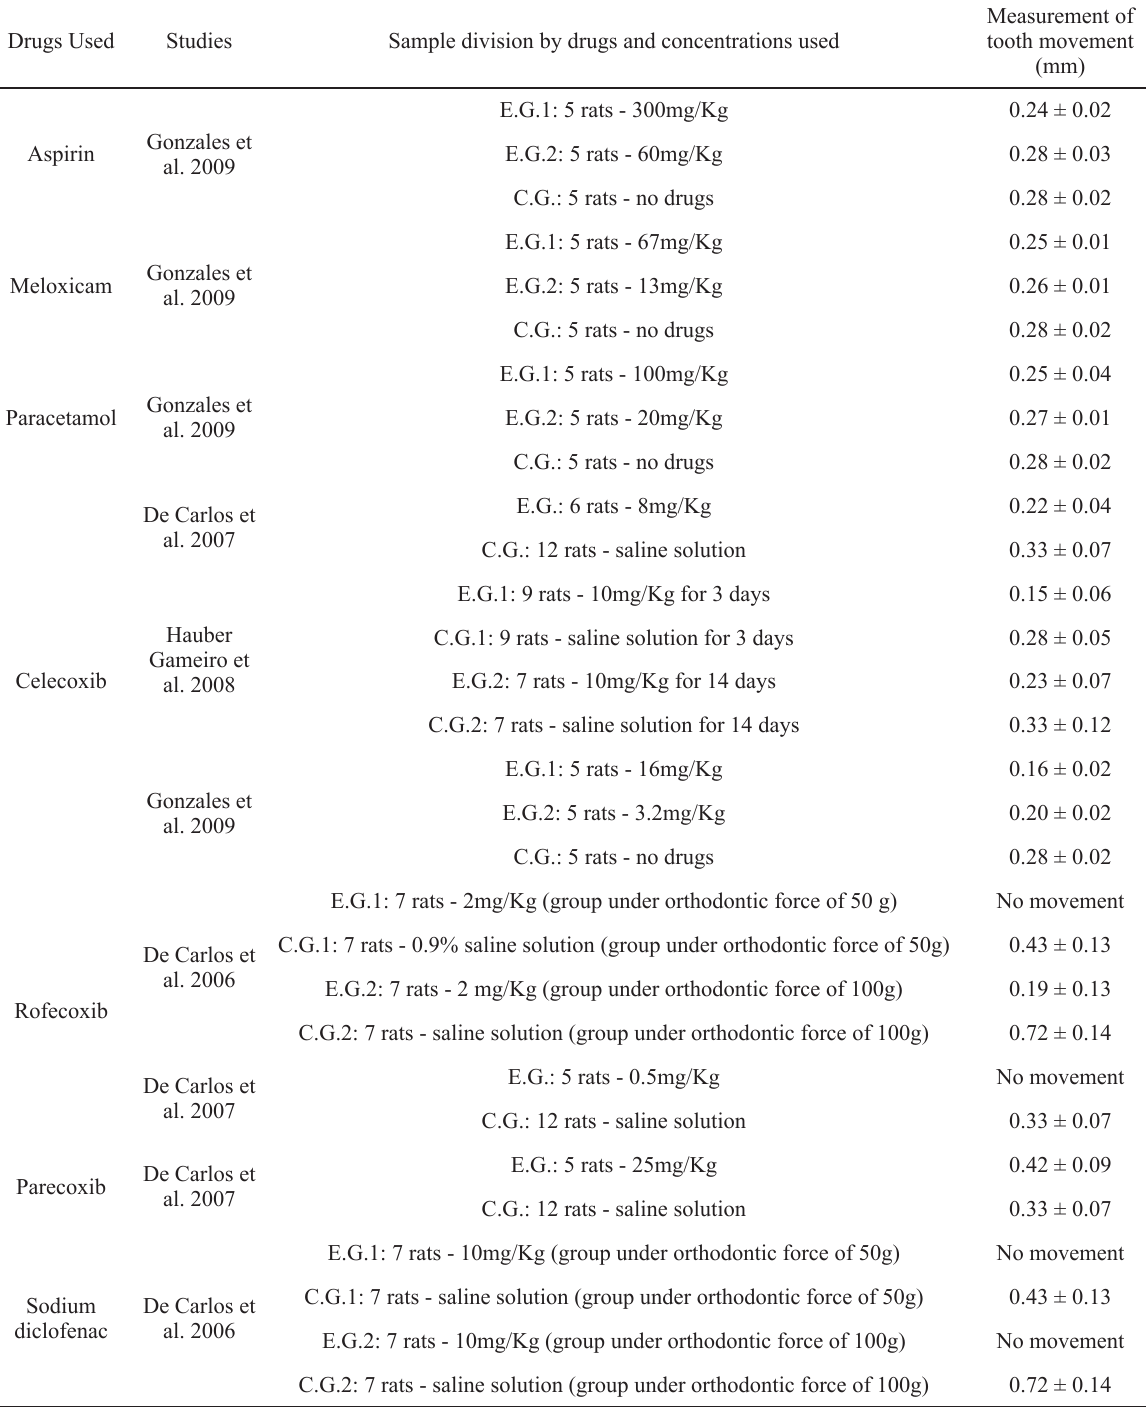
Influence of NSAIDs on orthodontic movement when assessing traction of the first maxillary